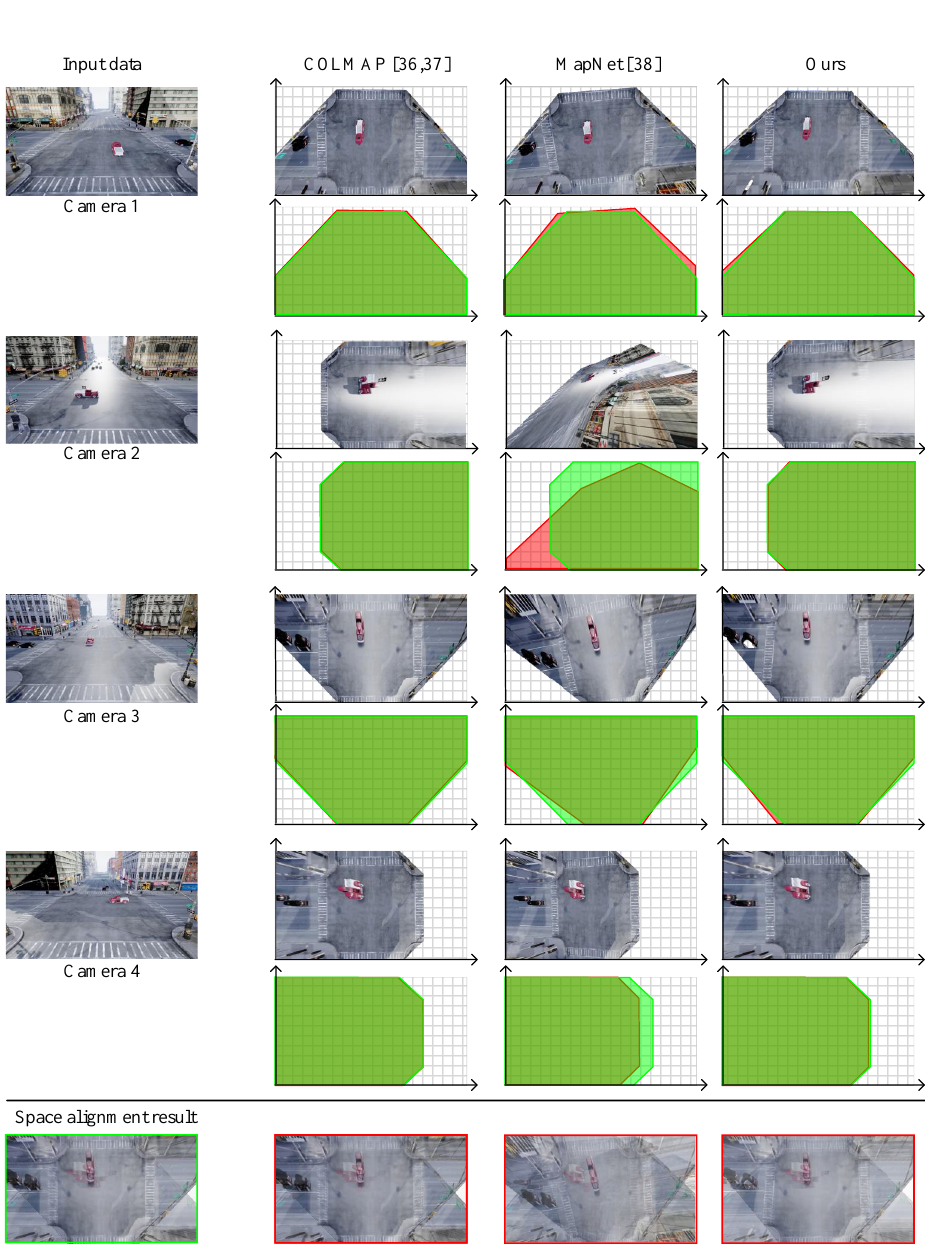
Figure 13. The comparison of multi-camera space alignment performance. The test scene is a crossroad with four monitoring cameras. The coordinate mapping results of each camera by COLMAP, MapNet and ours are provided from left to right. The space alignment result in the bottom marked in green is the ground